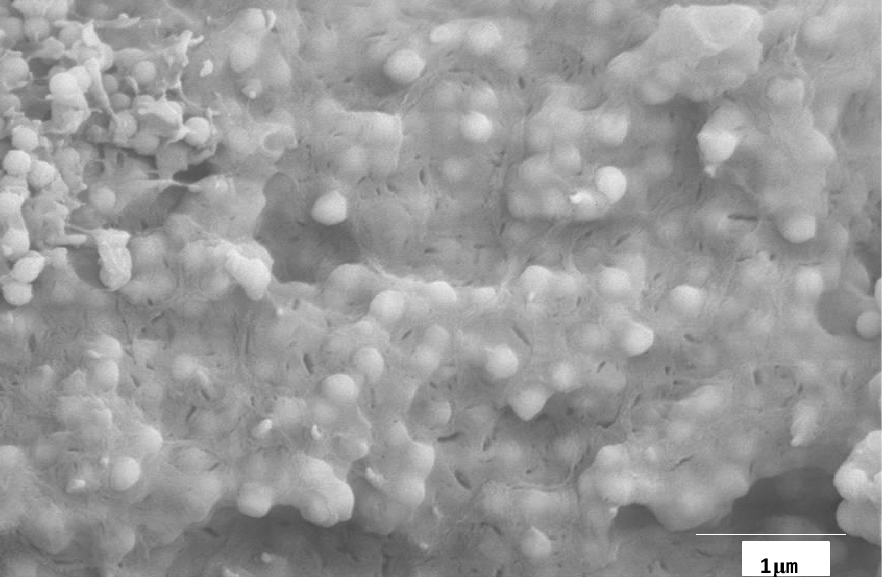
Figure 5. SEM micrograph of silica (monospheres) in an isotactic polypropylene matrix prepared by in-situ polymerization in the gas phase with rac-[Et-(IndH catalyst filler content 50 wt%, magnification 10,000×.